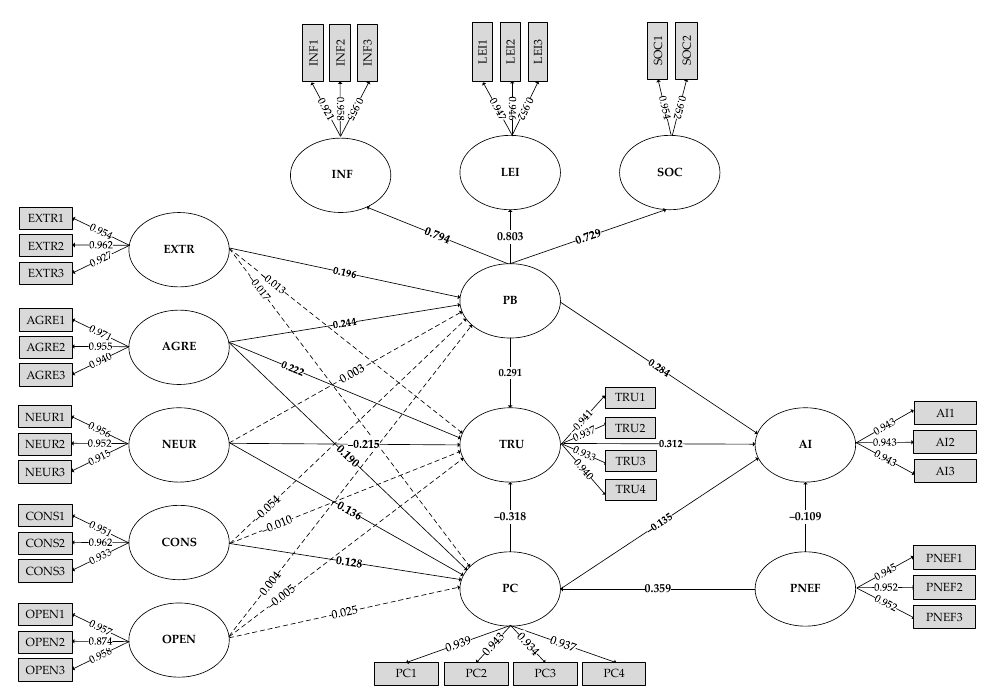
Figure 2. Path analysis coefficient. Table 7. Summary of hypotheses testing